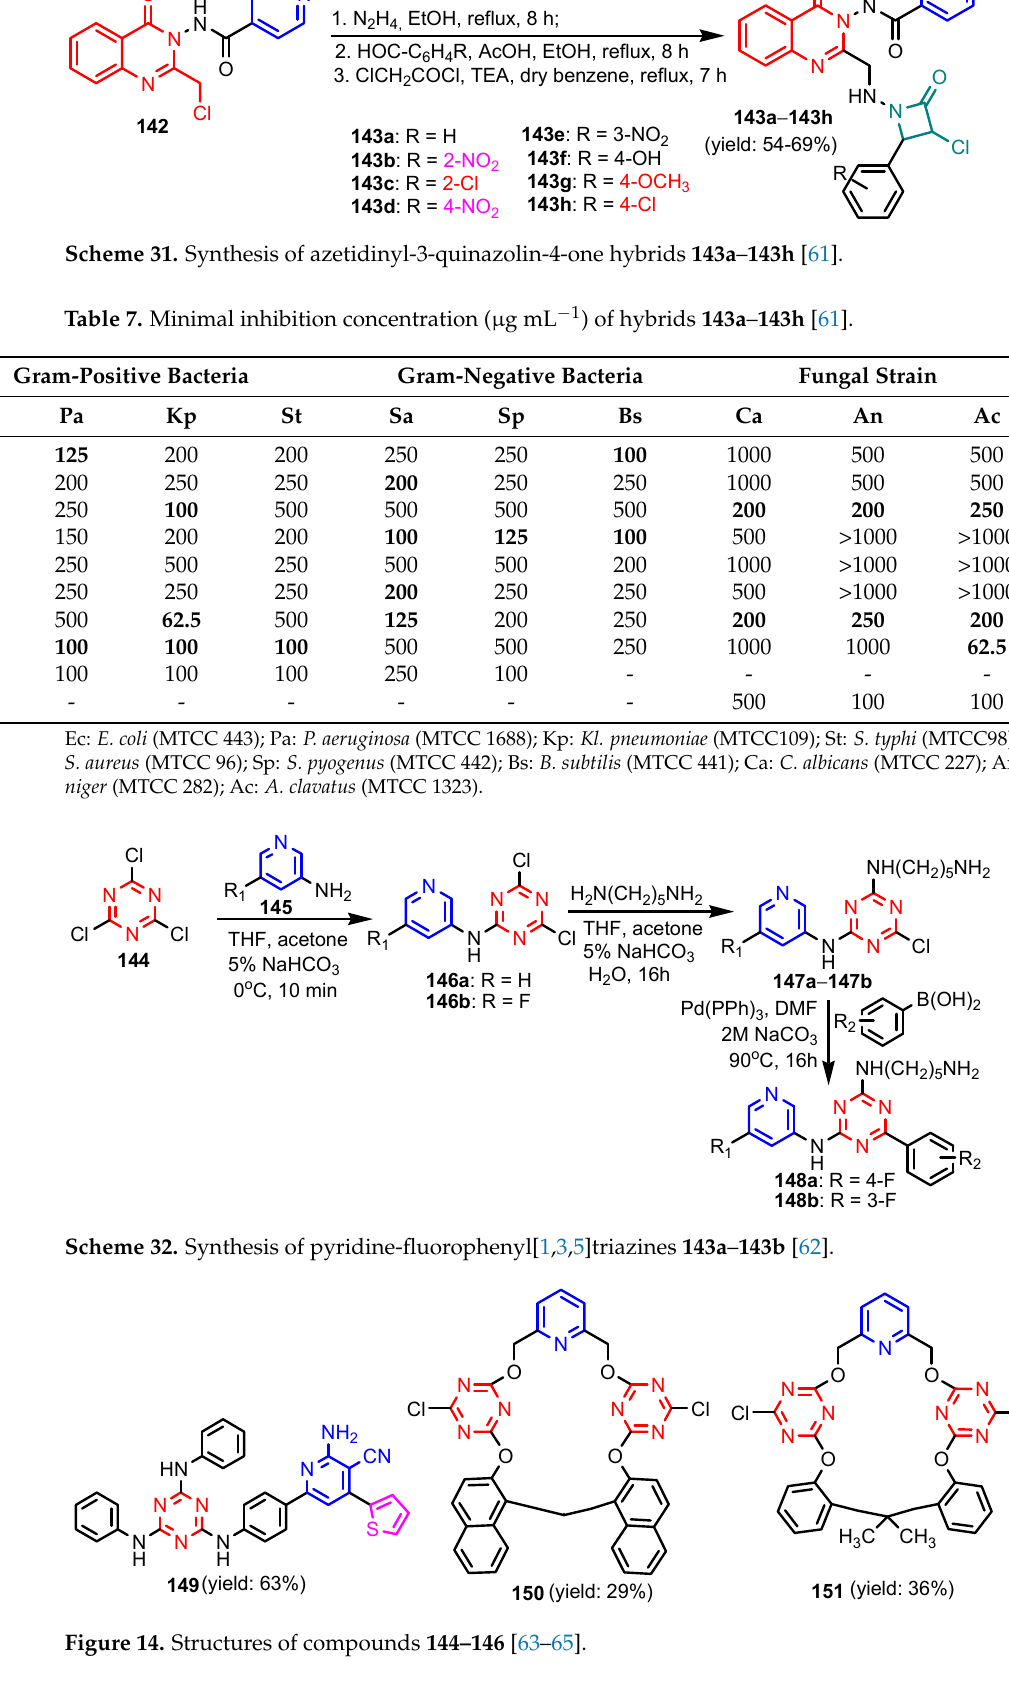
( b ) Figure 15. ( a ) Binding of oxacalixarene 151 with the covalent acyl enzyme (PDB ID: 1PW8). ( b ) The oxacalixarene substrate 151 bound to the binding site of quadruple mutant, showing the fitting of the test oxacalixarene on the substrate surface. 7. Synthesis of Antimicrobial Macrocyclic Pyridine Compounds Al-Salahi et al. [66] synthesized N 2 ,N 6 -bis(1-hydrazinyl-1-oxopropan-2-yl)pyridine- 2,6-dicarboxamide 153 , in three steps from pyridine-2,6-dicarboxylic acid 152 . Reaction of 153 with 1,2,4,5-benzenetetracarboxylic acid dianhydride or 1,4,5,8-naphthalene tetracar- boxylic acid dianhydride in refluxing acetic acid afforded the corresponding macrocyclic octaamide-tetraimide chiral pyridine derivatives 154 and 155 , respectively (Scheme 33). Table 8 shows that compounds 154 and 155 had significant antimicrobial activities against all tested strains, B. subtilis , S. aureus , E. coli , and C. albicans . Using a similar synthesis strategy, Abd El-Salam et al. [67] synthesized chiral macrocyclic polyamides 156 , 157 and 158a − 158f (Figure 16). As can be seen in Table 9, except for compounds 158b , 158d (against B. subtilis ) and 158c and 158e (against S. aureus ), the activities of the tested compounds against the Gram-positive bacteria are slightly higher than that of the reference drug Am- picillin. Compounds 156 and 158a also had better inhibitory activity than Ampicillin